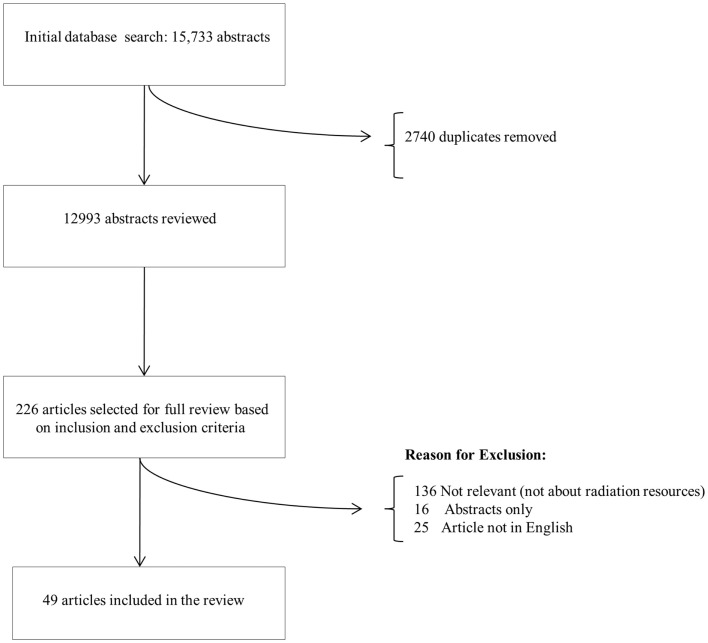
Article selection.